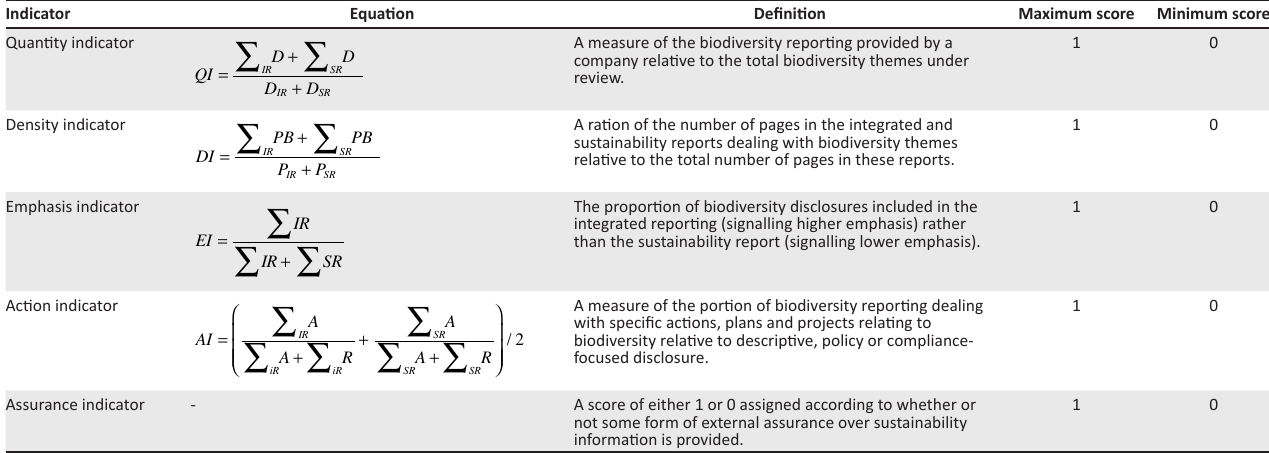
TABLE 4: Summary of quality index elements. Indicator